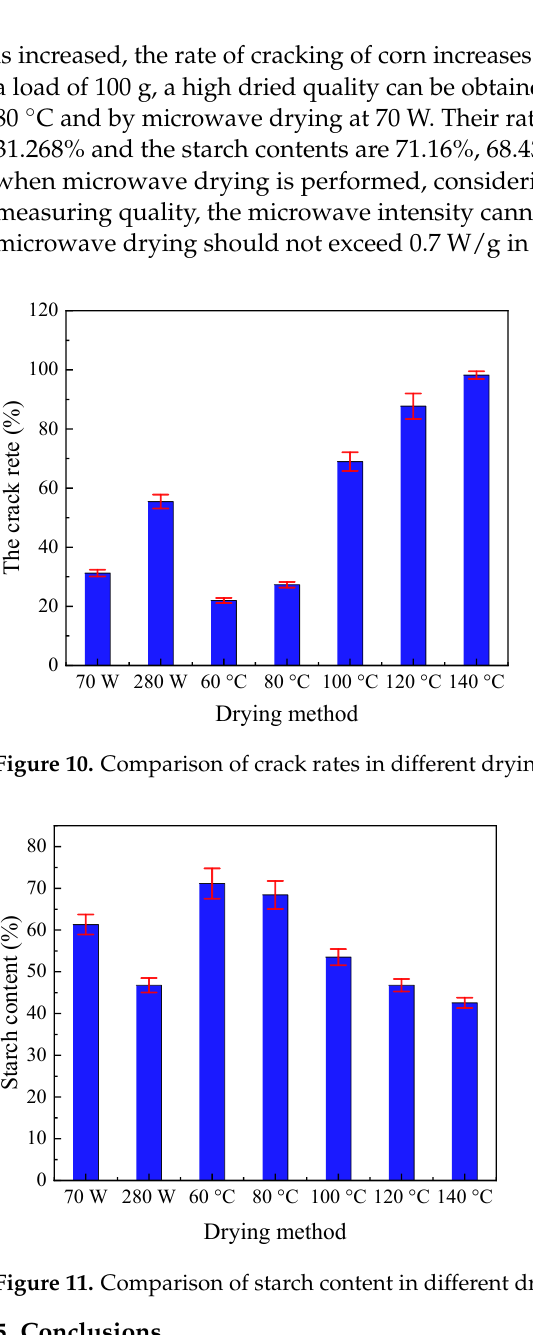
Figure 11. Comparison of starch content in different drying methods.